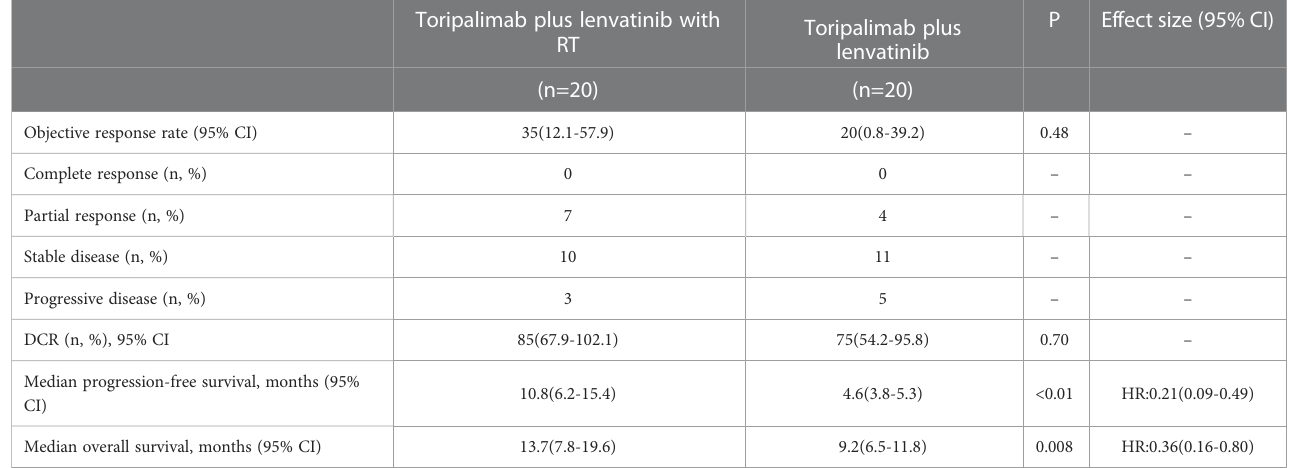
TABLE 2 Tumor response to treatment in each treatment group.